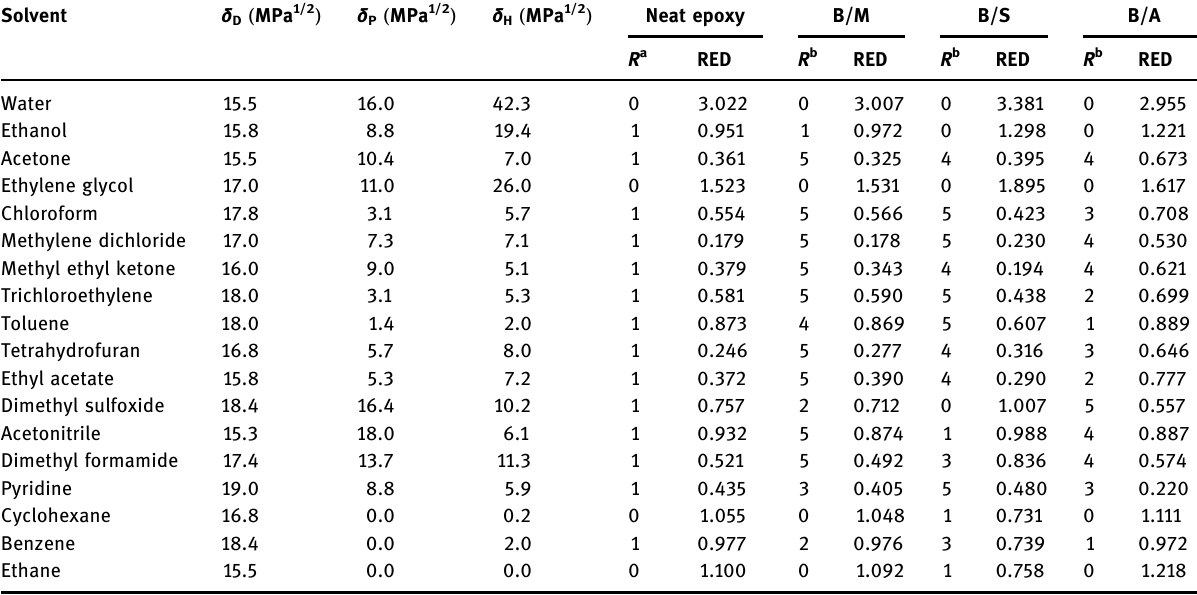
Table 1: The rating results and RED values of solubility or swelling of epoxy matrix and core/shell nanoparticles in various solvents with known HSP Solvent